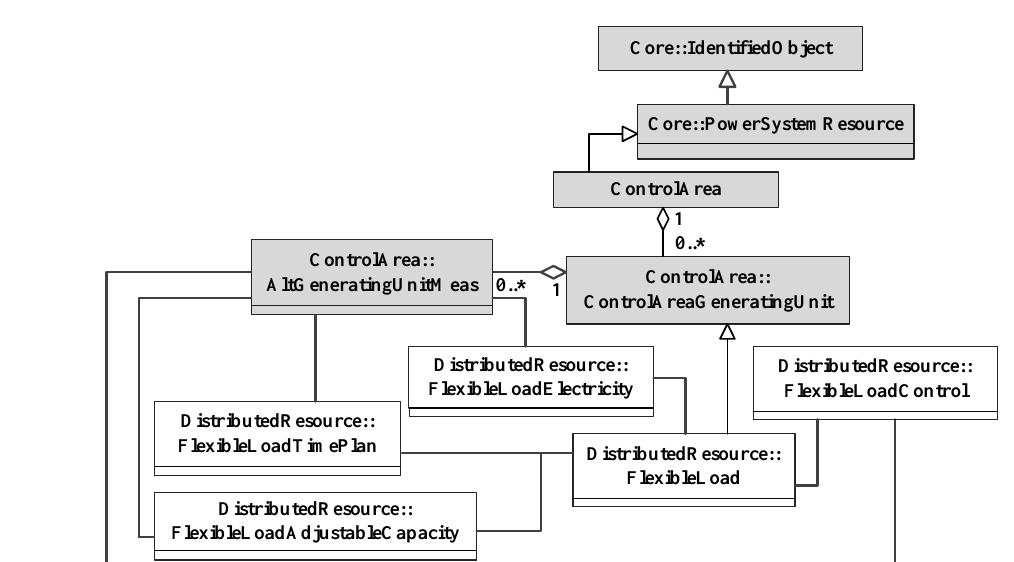
Figure 8. The simplified schematic class diagram for the distributed resource package.